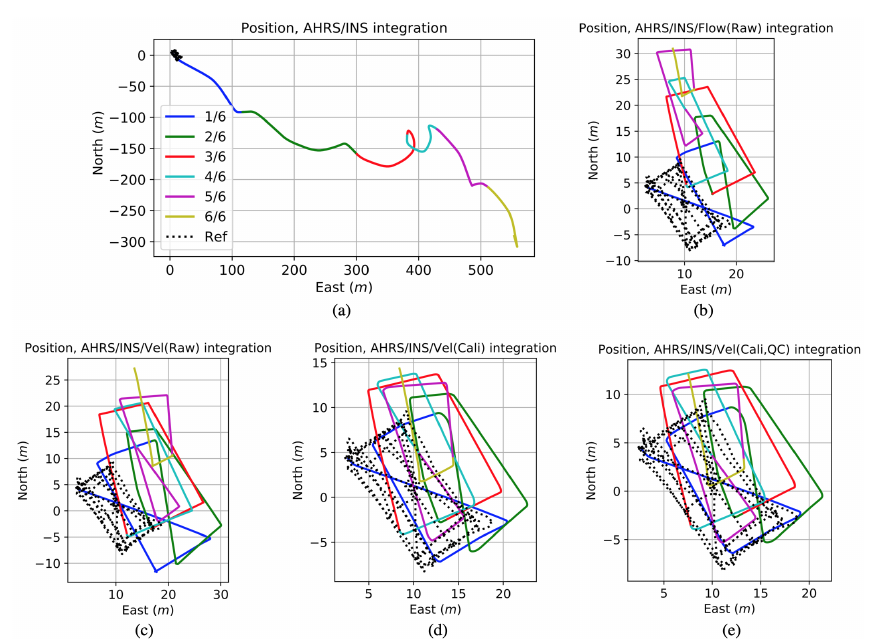
Figure 7. Attitude and heading reference system (AHRS)/inertial navigation system (INS)/Velocity integrated location solutions with various velocity strategies. ( a ) AHRS/INS solution; ( b ) AHRS/ INS/Flow(Raw) solution; ( c ) AHRS/INS/Vel(Raw) solution; ( d ) AHRS/INS/Vel(Cali) solution; ( e ) AHRS/INS/Vel(Cali,QC)